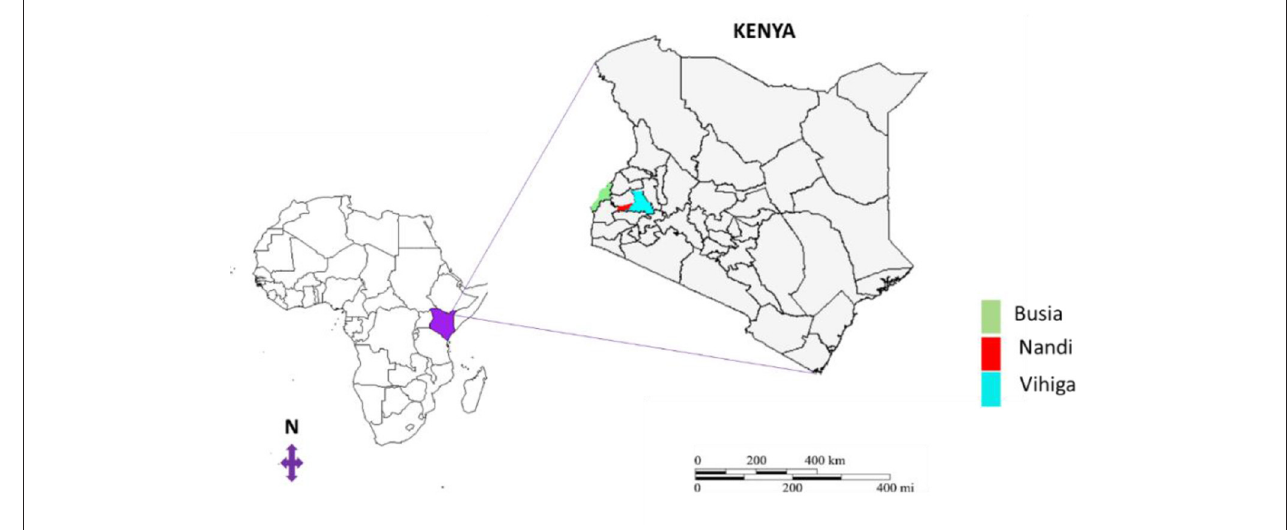
FIGURE 1 | The study sites Busia, Nandi, and Vihiga counties in western